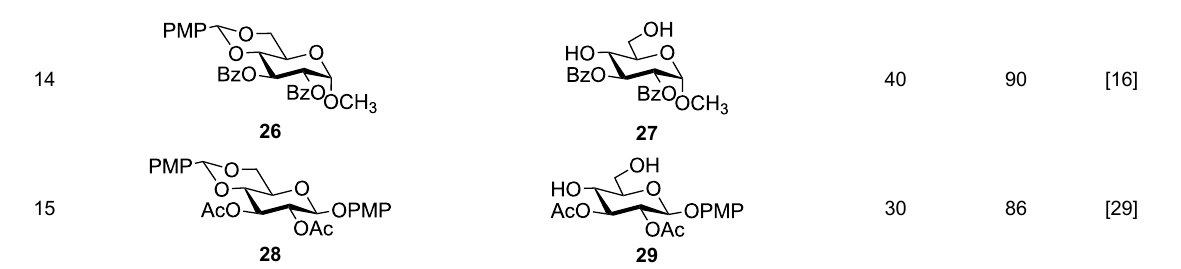
Table 1: Conversions of carbohydrate derivatives effected with Et 3 SiH and 10% Pd/C.